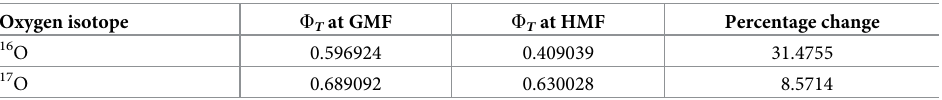
Table 2. Percentage change in fractional triplet yield as one goes from GMF to HMF for singlet-born RP for both 16 O and 17 O cases. a 6 s − 1 , and r = 2 × 10 5 s − 1 1 = − 802.9 μT , a 2 = 1886.8 μT , k = 2 × 10